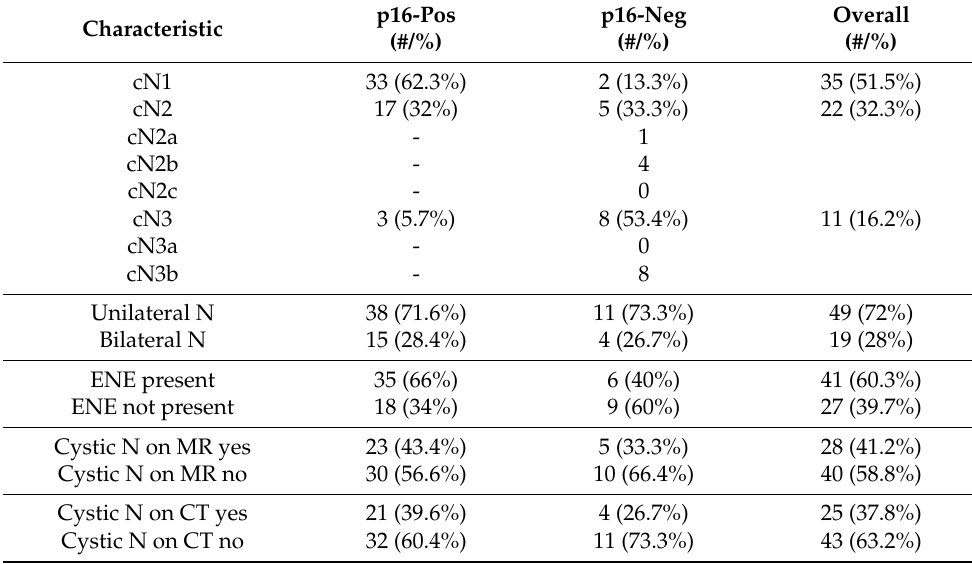
Table 1. Patients’